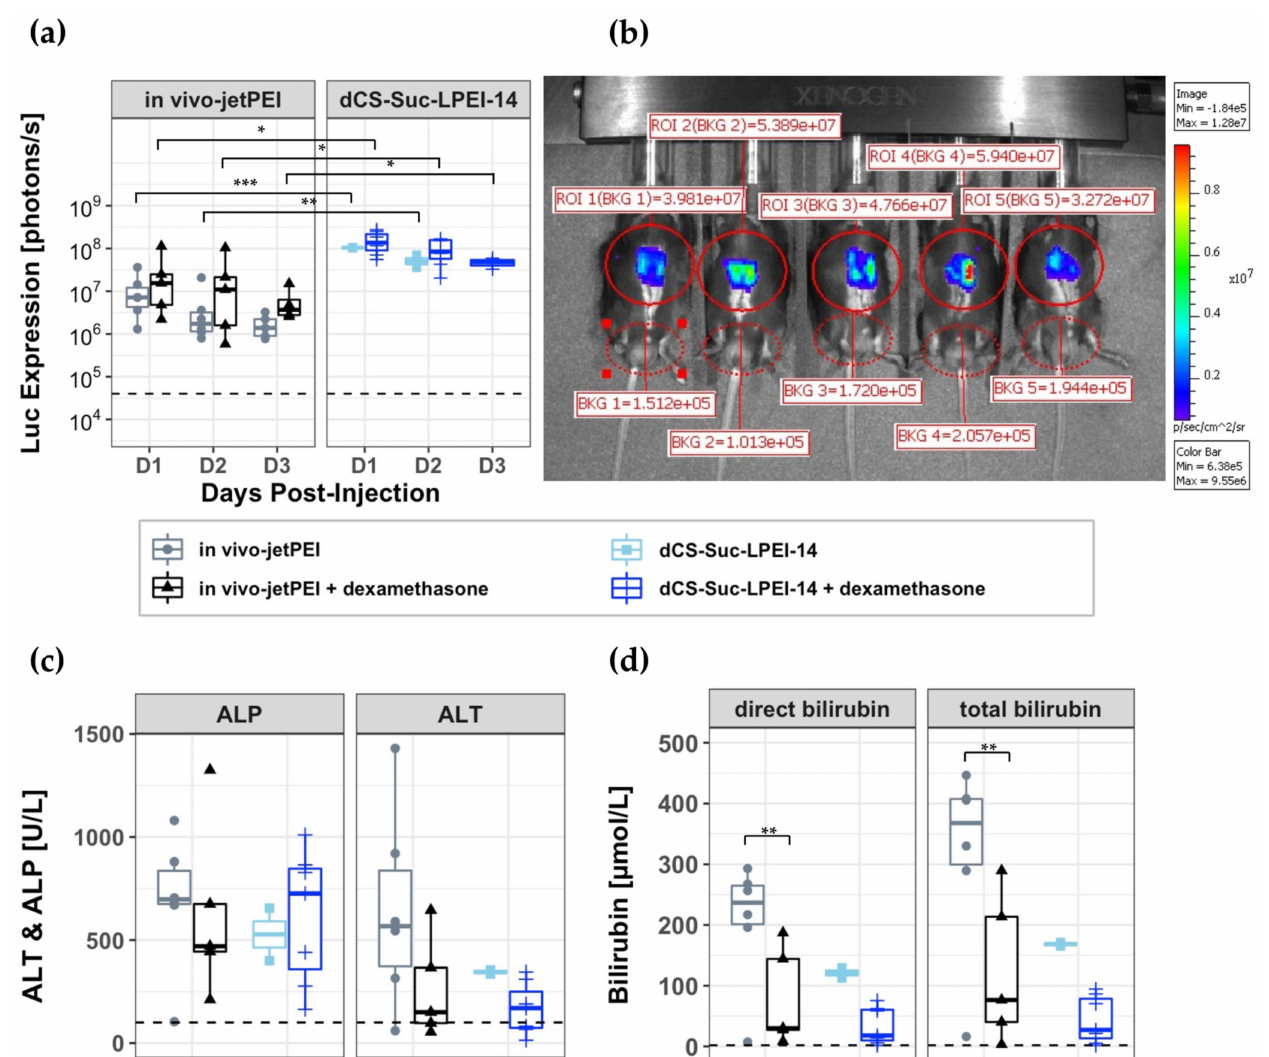
Figure 5. In vivo assessment of dCS-Suc-LPEI-14 upon retrograde intrabiliary infusion into wild-type mice. ( a ) Luciferase expression levels up to three days post retrograde intrabiliary infusion of 1 µ g nanovector-DNA encapsulated with a c/p ratio of 2 ( dCS-Suc-LPEI-14 ) and 1.1 (in vivo-jetPEI). Animals were pretreated without ( n = 6) or with dexamethasone ( n = 5) for in vivo-jetPEI, and without ( n = 2) or with dexamethasone ( n = 5) for dCS-Suc-LPEI-14 . Note that mice injected without dexamethasone showed signs of jaundice and severe cases had to be euthanized (and were therefore not screened for IVIS). ( b ) Detection of liver-associated bioluminescence in mice three days post intrabiliary infusion (1 µ g DNA/ dCS-Suc-LPEI-14 + dexamethasone). ( c , d ) Serum markers for hepatotoxicity, including alkaline phosphatase (ALP), alanine transaminase (ALT), total bilirubin, and direct bilirubin. Statistical differences by Student’s two tailed t -test: * = p < 0.05, ** = p < 0.01, *** = p < 0.001. Dashed line: background = untreated mice. Values are means ± SD, n ≥